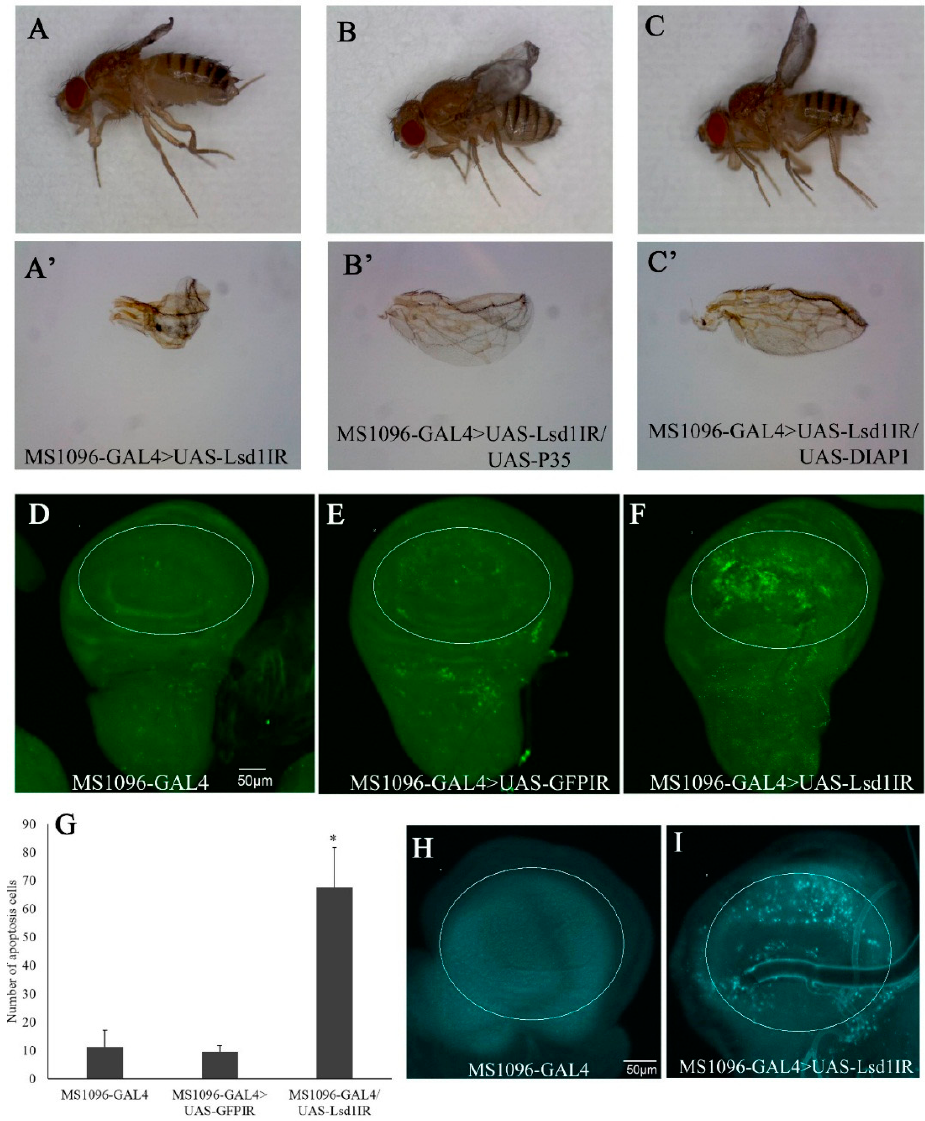
Figure 3. Knockdown of Lsd1 induces cell death in wing imaginal discs. The atrophied wing phenotype of Lsd1 -knockdown flies was rescued by P35 ( B , B’ ) and DIAP1 ( C , C’ ); ( A , A’ ) MS1096-GAL4 > UAS- Lsd1 IR; ( B , B’ ) MS1096-GAL4/+; UAS- Lsd1 IR/+; UAS-P35/+ (MS1096-GAL4 > UAS- Lsd1 IR/UAS-P35); ( C , C’ ) MS1096-GAL4/+; UAS- Lsd1 IR/+; UAS-DIAP1/+ (MS1096-GAL4 > UAS- Lsd1 IR/UAS-DIAP1); ( D – F ) immunostaining of wing imaginal discs with anti-active caspase-3 antibody; Control lines, MS1096-GAL4 ( D ) and MS1096-GAL4 > UAS- GFP IR ( E ); showed few cell death signals, while Lsd1 -knockdown line MS1096-GAL4 > UAS- Lsd1 IR ( F ) showed increased cell death signals via apoptosis; ( G ) average number of apoptotic cells in the wing pouch ( n = 10); *, p < 0.05. Data are expressed as the mean ± S.D; ( H , I ) autophagy was determined by LysoTracker staining; ( H ) the control fly MS1096-GAL4; ( I ) Lsd1 -knockdown fly MS1096-GAL4 > UAS- Lsd1 IR. The circle indicates the wing pouch of the wing disc. The flies were reared at 25 °C.